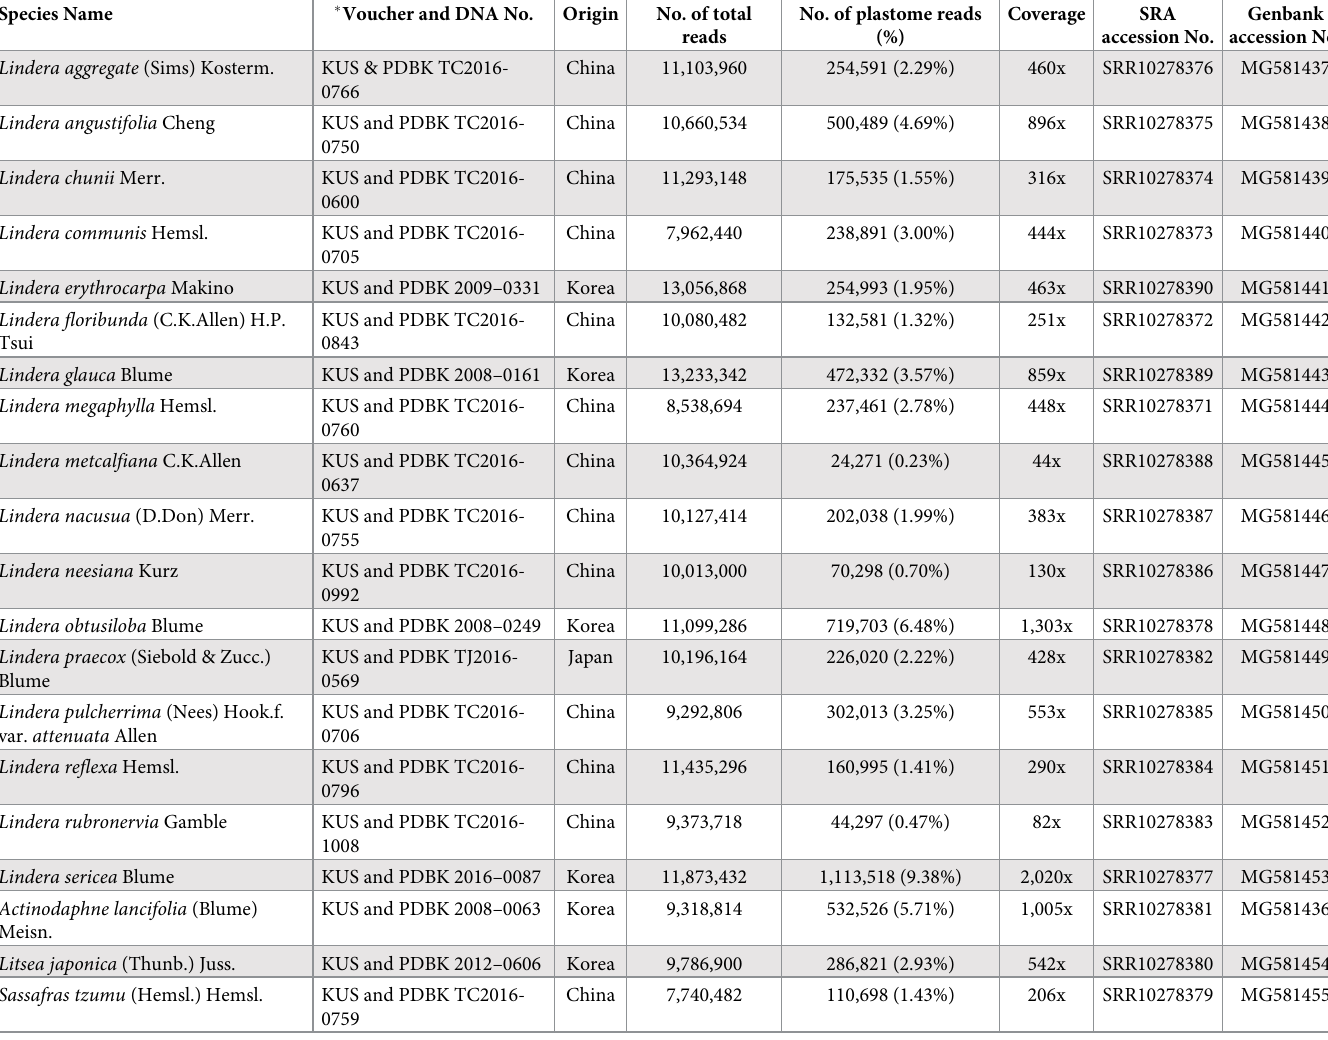
Table 1. Voucher information and summarized results of Illumina sequencing. All voucher specimens are deposited in Korea University herbarium (KUS) and DNAs are deposited in Plant DNA Bank of